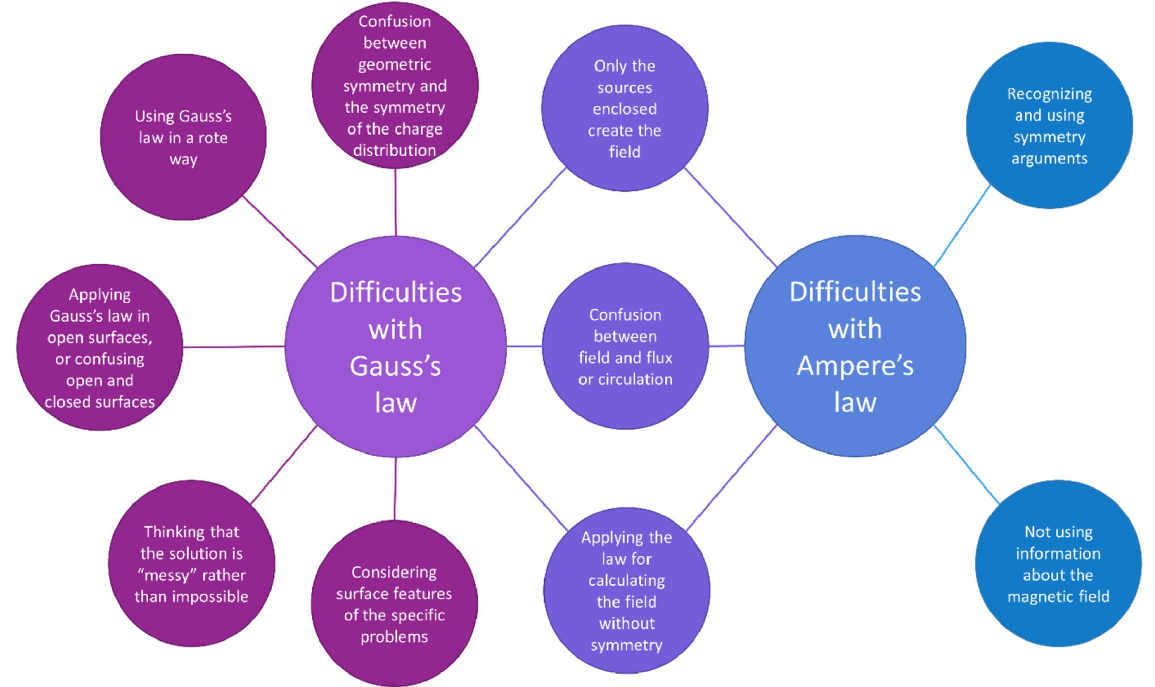
FIG. 1. Comparison of the most relevant findings in the literature of students ’ difficulties when understanding and applying symmetry in Gauss ’ s and Ampere ’ s laws. The bubbles on the left side of the figure represent the difficulties of Gauss ’ s law, and on the right side for Ampere ’ s law. The bubbles in the middle are difficulties found in both